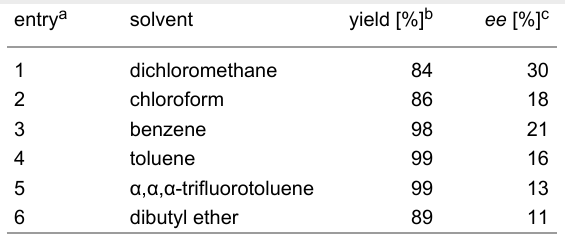
Table 2: Influence of the solvent on the bisamidine catalyzed Diels- Alder reaction. entry a